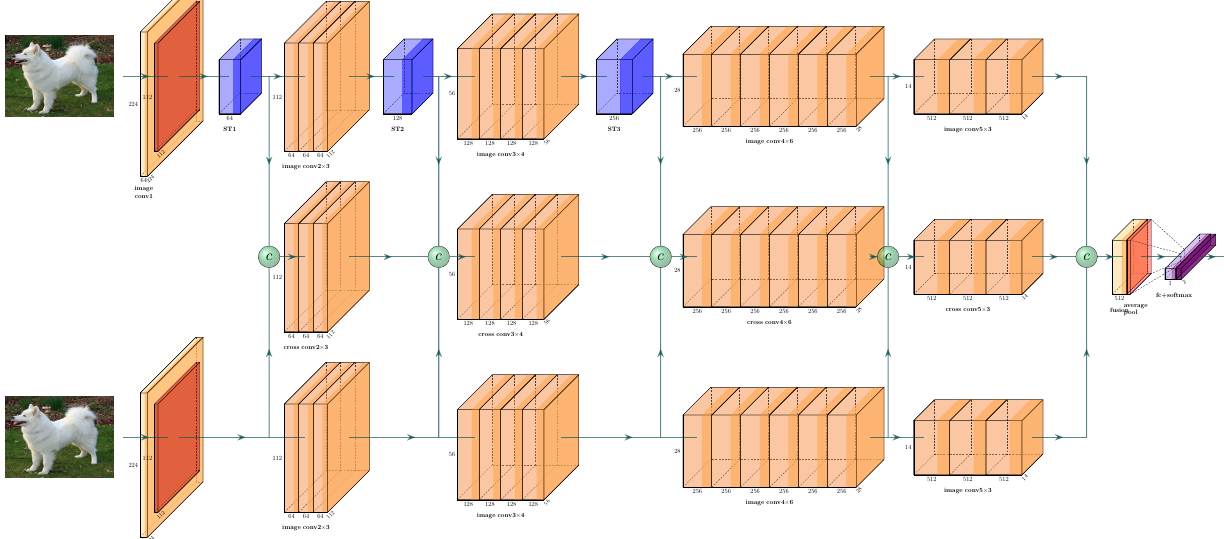
Figure 1. Illustration of spatial transformer-comparing convolutional neural network (ST-CCNN) architecture. The input images (showing in a slightly cropped image pair) are fed into two image streams (top and bottom), each of which consists of a convolutional block and four residual blocks. The cross stream (middle) shares the later residual blocks with the image streams. Feature maps of these three streams are fused by concatenation and convolutional layers to a vector into a fully connected layer and a Softmax